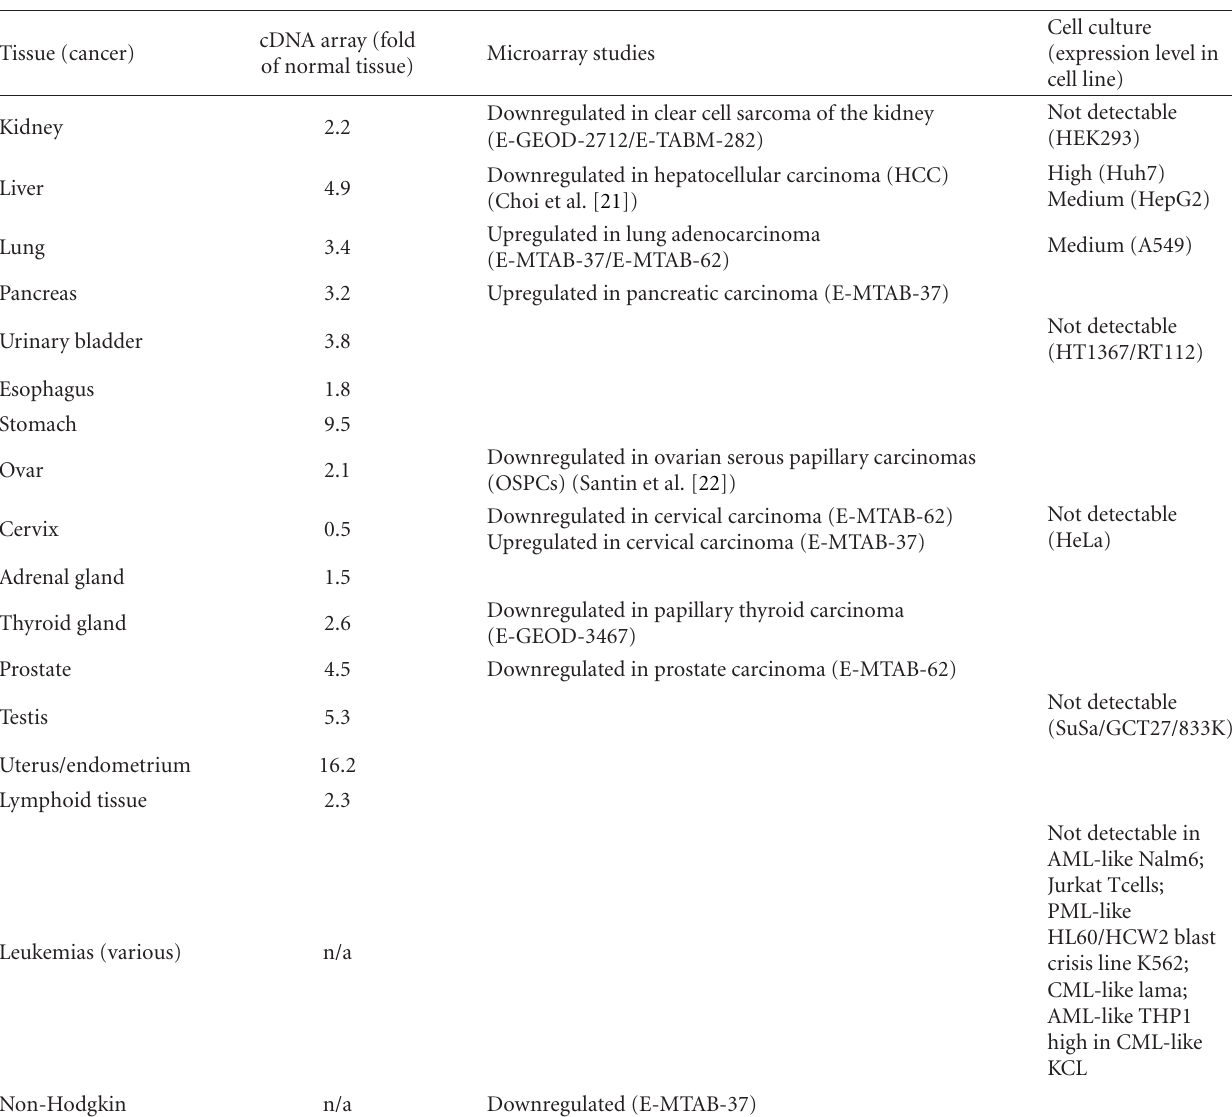
Table 2: Expression levels of PON3 in various tumor tissues and/or cancer cell cultures. Microarray experiment (array express) listings are according to the Gene Atlas Database. cDNA levels according to [24]. Cell culture expression levels were roughly estimated as relative level comparing to A549, grouped into low, medium, or high